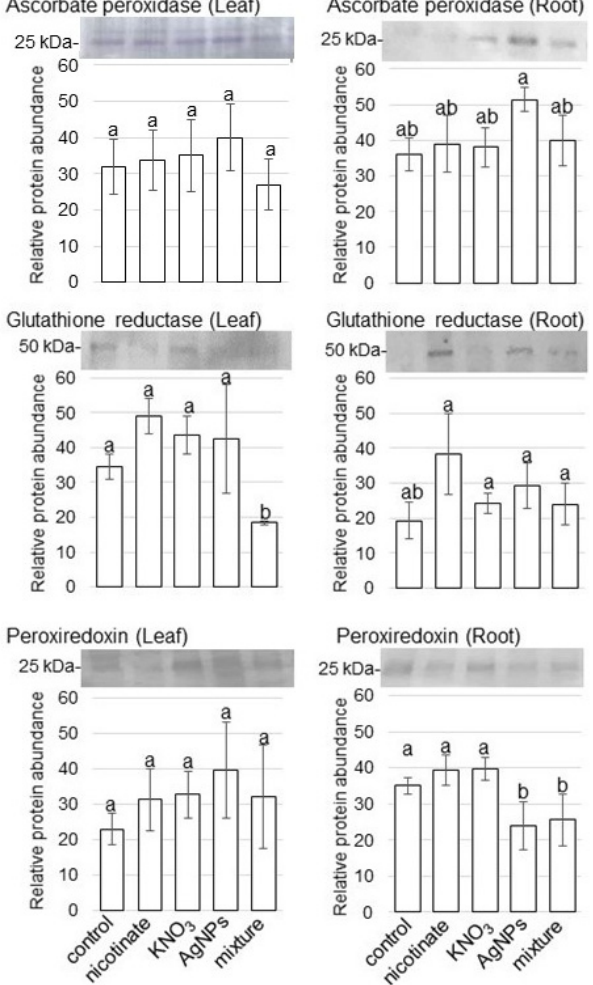
Figure 4. Accumulation of ROS scavenging enzymes in wheat treated with AgNPs/nicotinate/KNO 3 . Three-day-old wheat seedlings were treated with and without 8 mM nicotinate, 0.1 mM KNO 3 , 5 ppm AgNPs, and 5 ppm AgNPs/8 mM nicotinate/0.1 mM KNO 3 (mixture) for 3 days. Proteins (10 µ g) extracted from leaves and roots were separated on SDS-PAGE and immunoblot analyses were performed with anti-ascorbate peroxidase, glutathione reductase, and peroxiredoxin antibodies. The integrated densities of bands were calculated using ImageJ software. The data are presented as the mean ± SD from 3 independent biological replicates (Figures S2 and S3). Statistical analysis is the same as Figure 2.